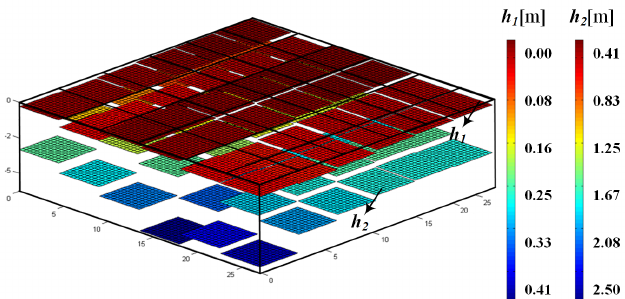
Figure 25. Visualization of mapping without interpolation of Leptosol’s profile.